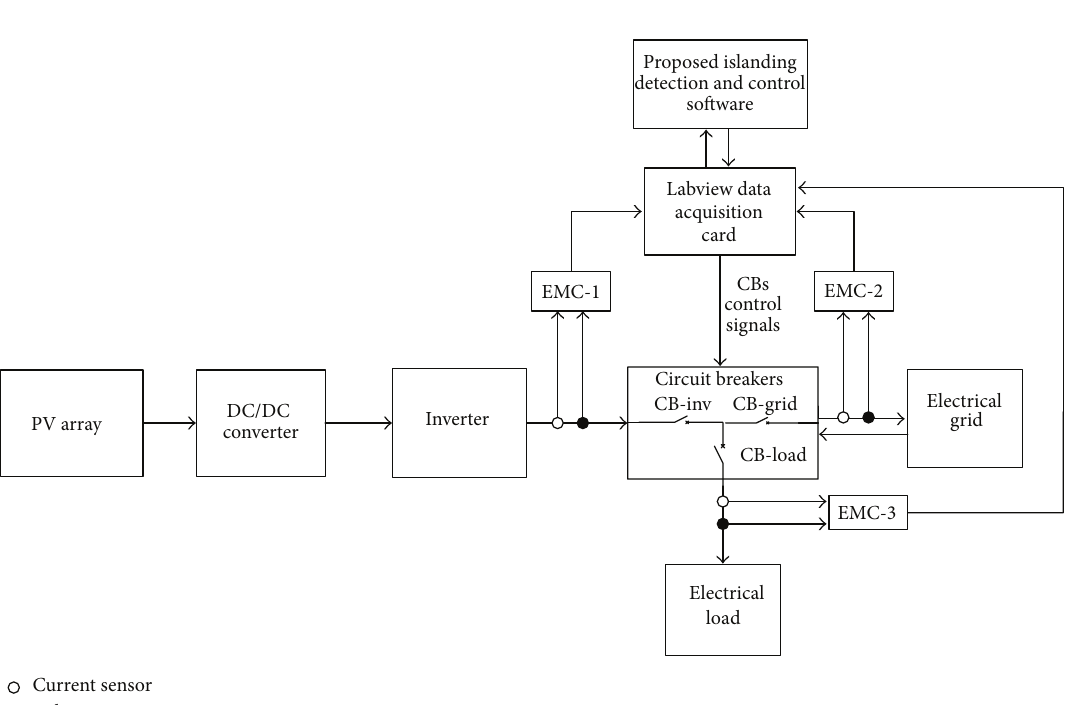
Figure 13: The general structure of developed grid tied PV system and proposed islanding detection test